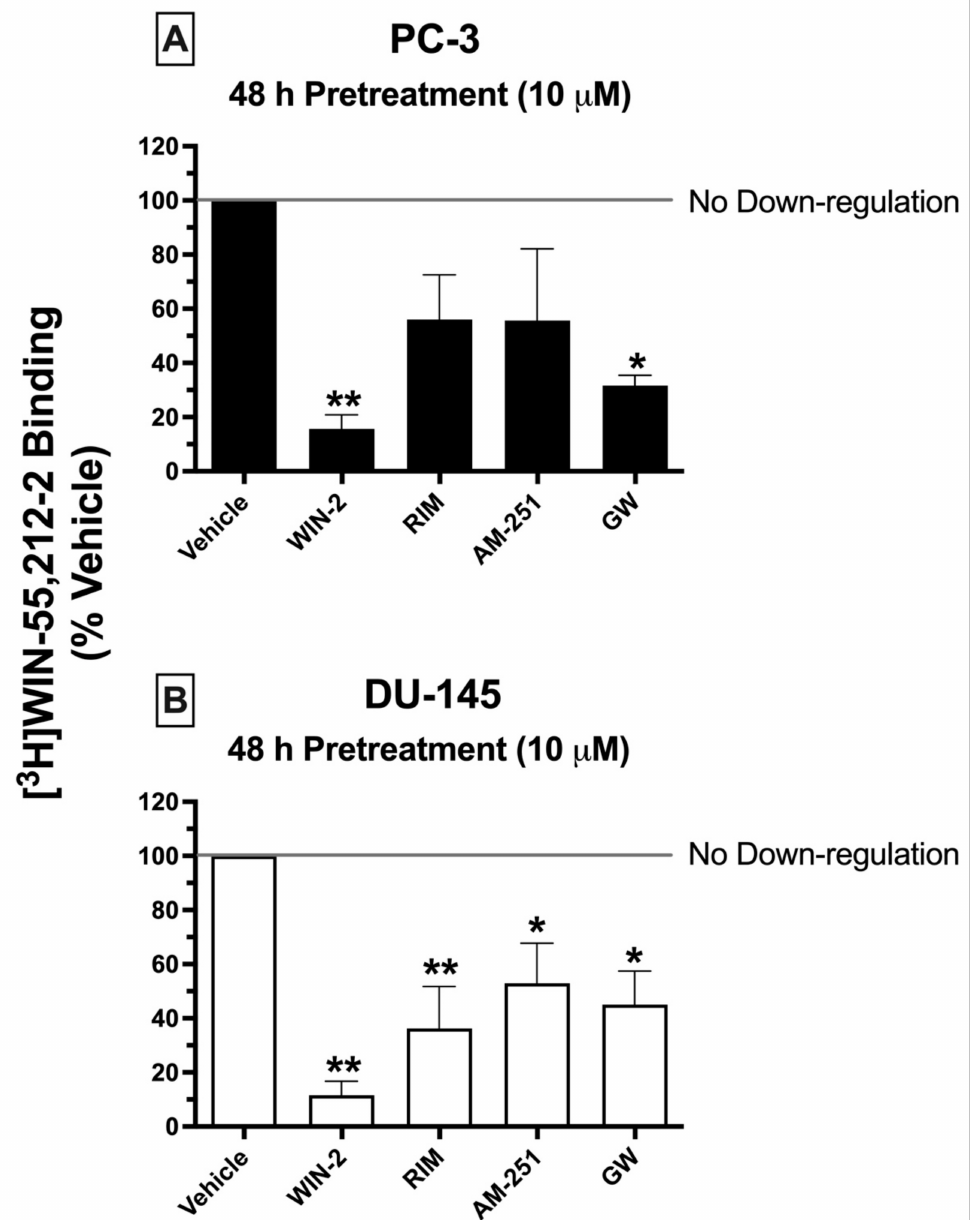
Figure 6. Chronic treatment of cells with CBR ligands: prolonged exposure of DU-145 and PC-3 cells to both high affinity CBR agonists and antagonists/inverse agonists results in CBR downregula- tion. PC-3 ( A ) and DU-145 ( B ) cells were cultured for 48 h in the presence of a receptor-saturating concentration (10 µ M) of the different CBR ligands examined. Following chronic treatment, cells were thoroughly washed to remove residual drug, harvested, and cell lysates were prepared. Bars represent the amount of specific [ 3 H]-WIN-55,212-2 binding (1 nM) remaining as compared to cells treated for 48 h with vehicle only and are presented as the means ± SEM of data collected from a minimum of three experiments. Significantly different from 100% (one-sample t -test, * p < 0.05, ** p <